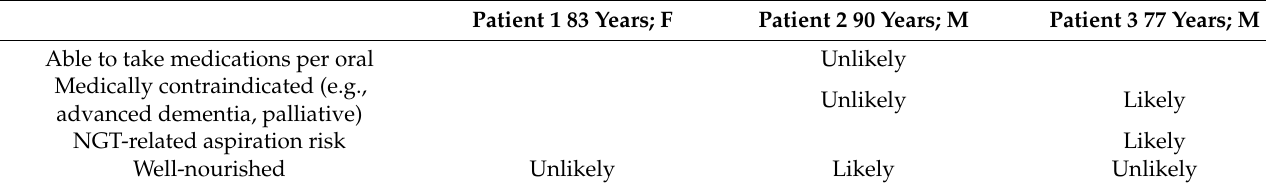
Table 4. Profile of patients offered